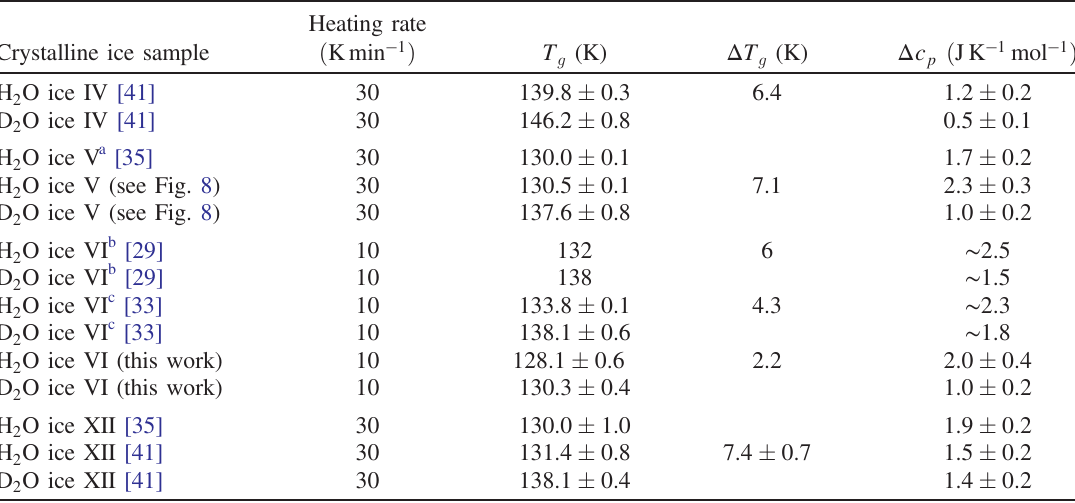
), difference in T between H 2 O and D 2 O ( Δ T g g